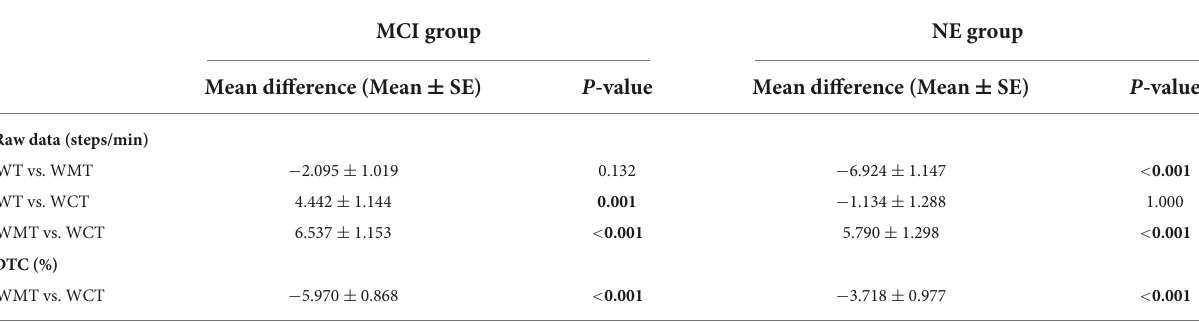
TABLE 6 Paired comparison of fqCADENCE parameters (raw date and DTC) in different tasks respectively.